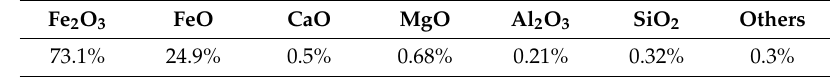
Table 2. Concentrate compositions (mass